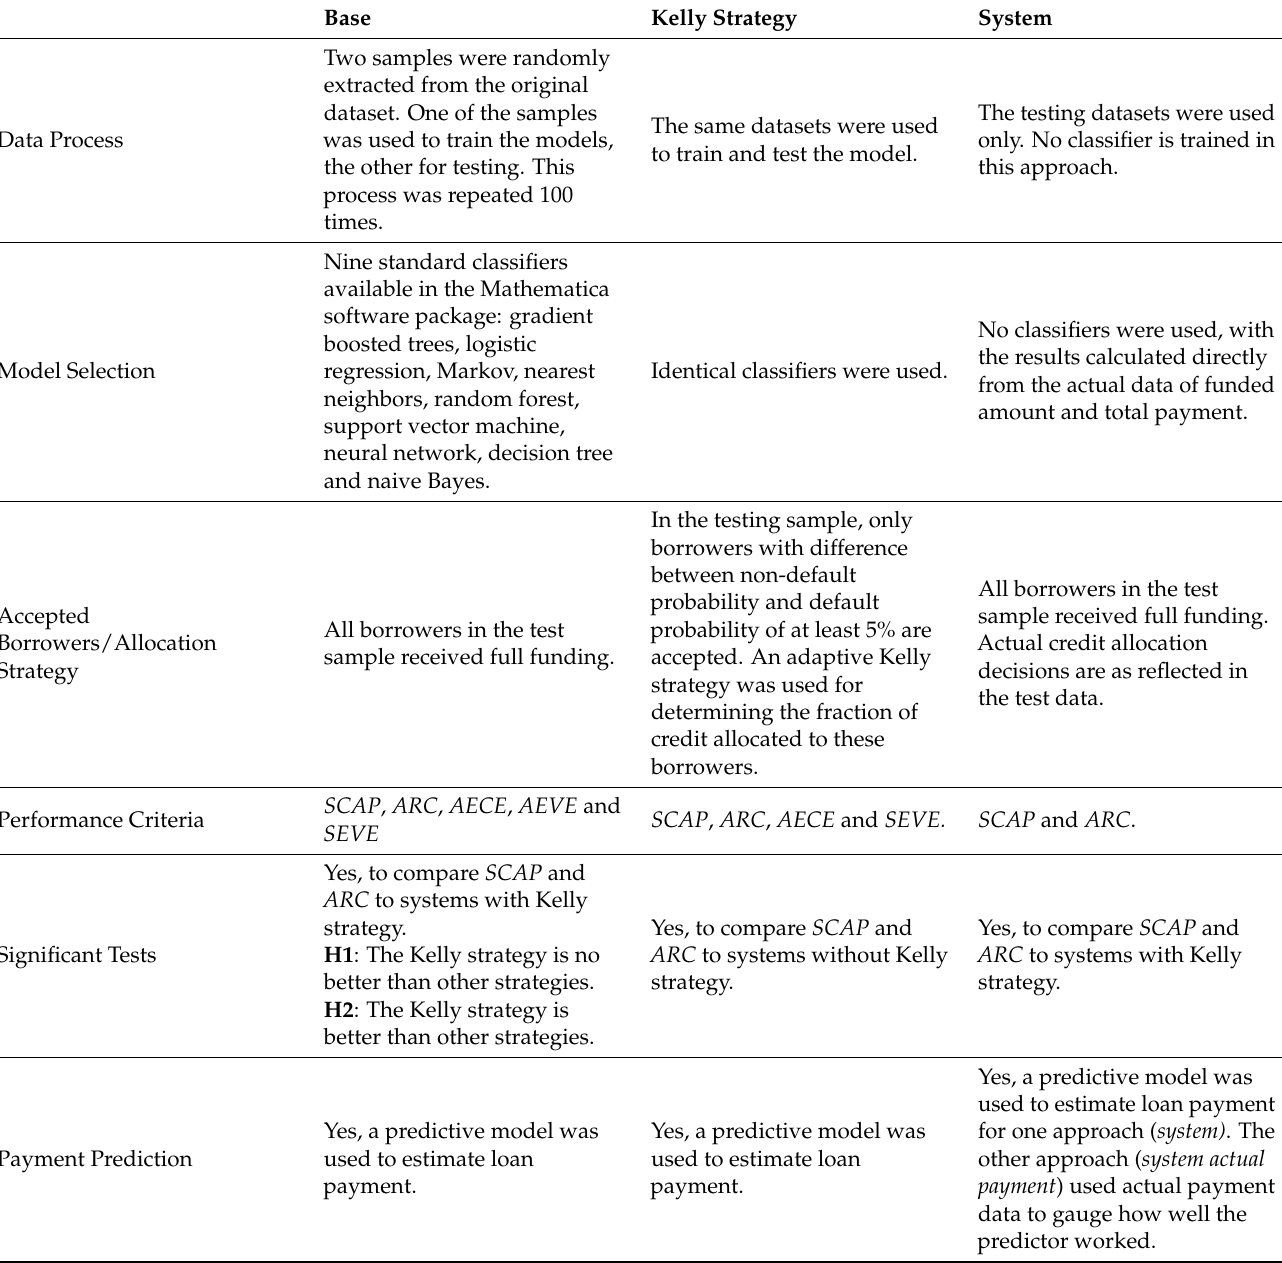
Table 1. Summary of the credit allocation